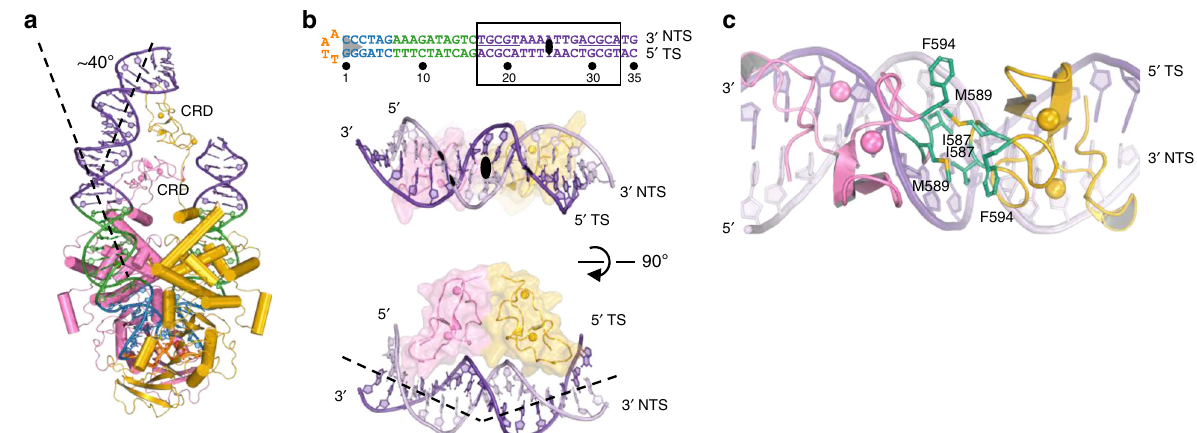
Fig. 3 C-terminal CRD binding generates asymmetry. a Cysteine-rich domain (CRD) dimer binds the palindromic 19-bp internal repeat of only one LE TIR, resulting in a ~40° kink of the DNA. DNA is colored as in Fig. 1d. Individual monomers are shown in yellow and pink. Bound Zn 2 + ions are rendered as spheres. b Close-up view of the CRD dimer – DNA interaction. Top, sequence and numbering of hairpin DNA in the SNHP complex. The palindrome within bp 17 – 33 (purple) is underlined, and the two-fold symmetry axis is indicated. Bottom, orthogonal views of the CRD dimer. DNA binding by the CRDs narrows the minor groove centered at ~bp 25. NTS non-transferred strand, TS transferred strand. c Hydrophobic residues at the CRD dimer